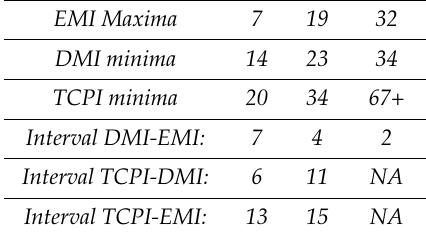
Figure 12. Comparison between the third modes of TCPI, DMI and El Niño Modoki using Dataset-3. A minima in El Niño Modoki drives maxima in DMI and TCPI. Table 8. Peaks in the EMI (Figure 10) and the corresponding valleys in the DMI followed by a dip in the